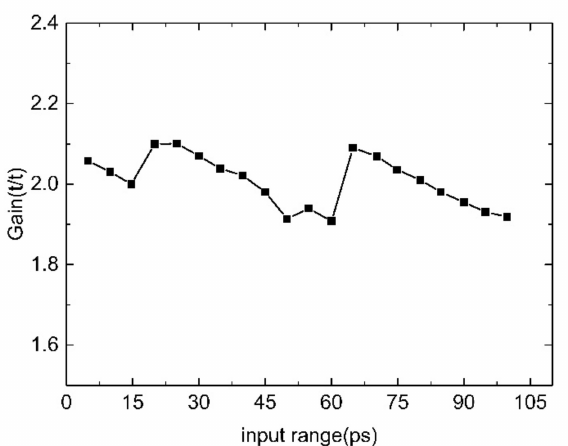
Figure 9. Dynamic range simulation of